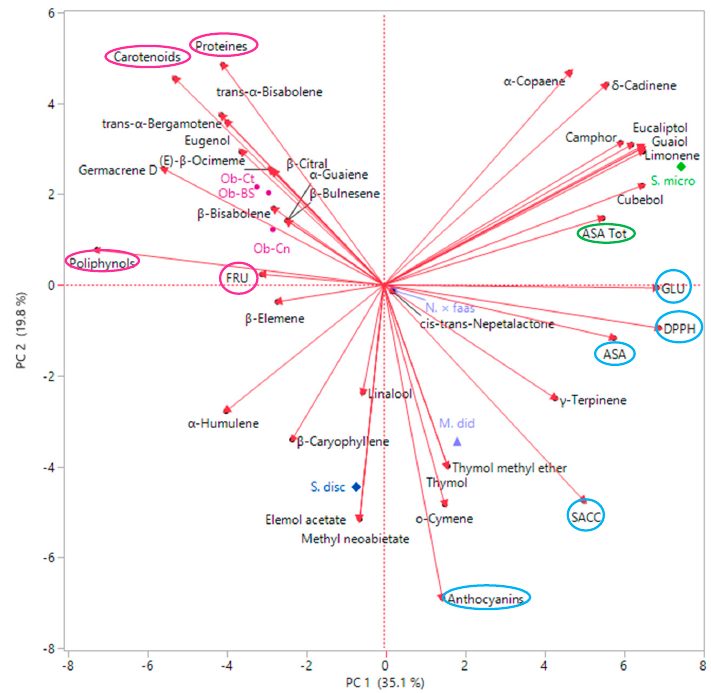
Figure 3 . PCA Plot depicting phytochemical proximities among VOCs of the studied spp. 211 Figure 3. Principal component analysis (PCA) plot depicting phytochemical proximities among VOCs of the studied spp.